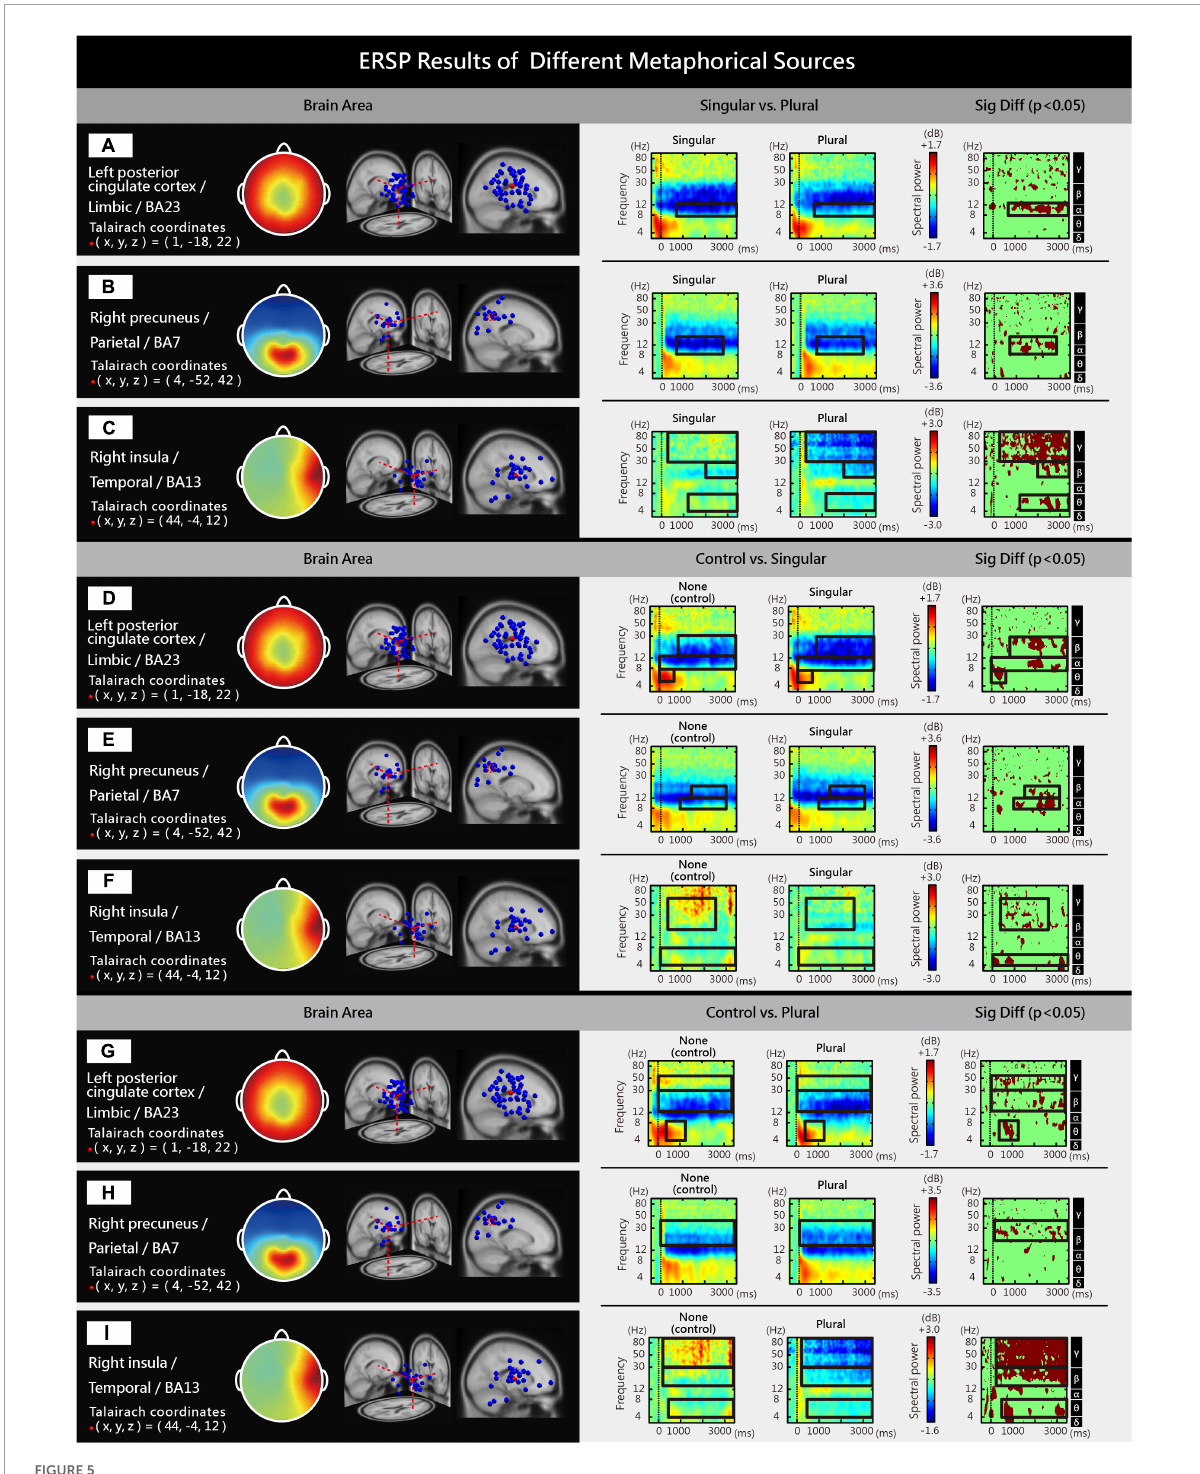
FIGURE5 Significant differences were observed in the ERSPs of different brain areas among marketing images with different numbers of metaphorical sources: (A,D,G) In the left PCC, the spectral power of plural metaphorical sources was higher than that of singular metaphorical sources, while the spectral power of no metaphorical source was higher than that of both singular and plural metaphorical sources. (B,E,H) In the right precuneus, the spectral power of plural metaphorical sources was higher than that of singular metaphorical sources, while the spectral power of no metaphorical sources was higher than that of both singular and plural metaphorical sources. (C,F,I) In the right insula, the spectral power of singular metaphorical sources was higher than that of plural metaphorical sources, while the spectral power of no metaphorical sources was higher than that of both singular and plural metaphorical